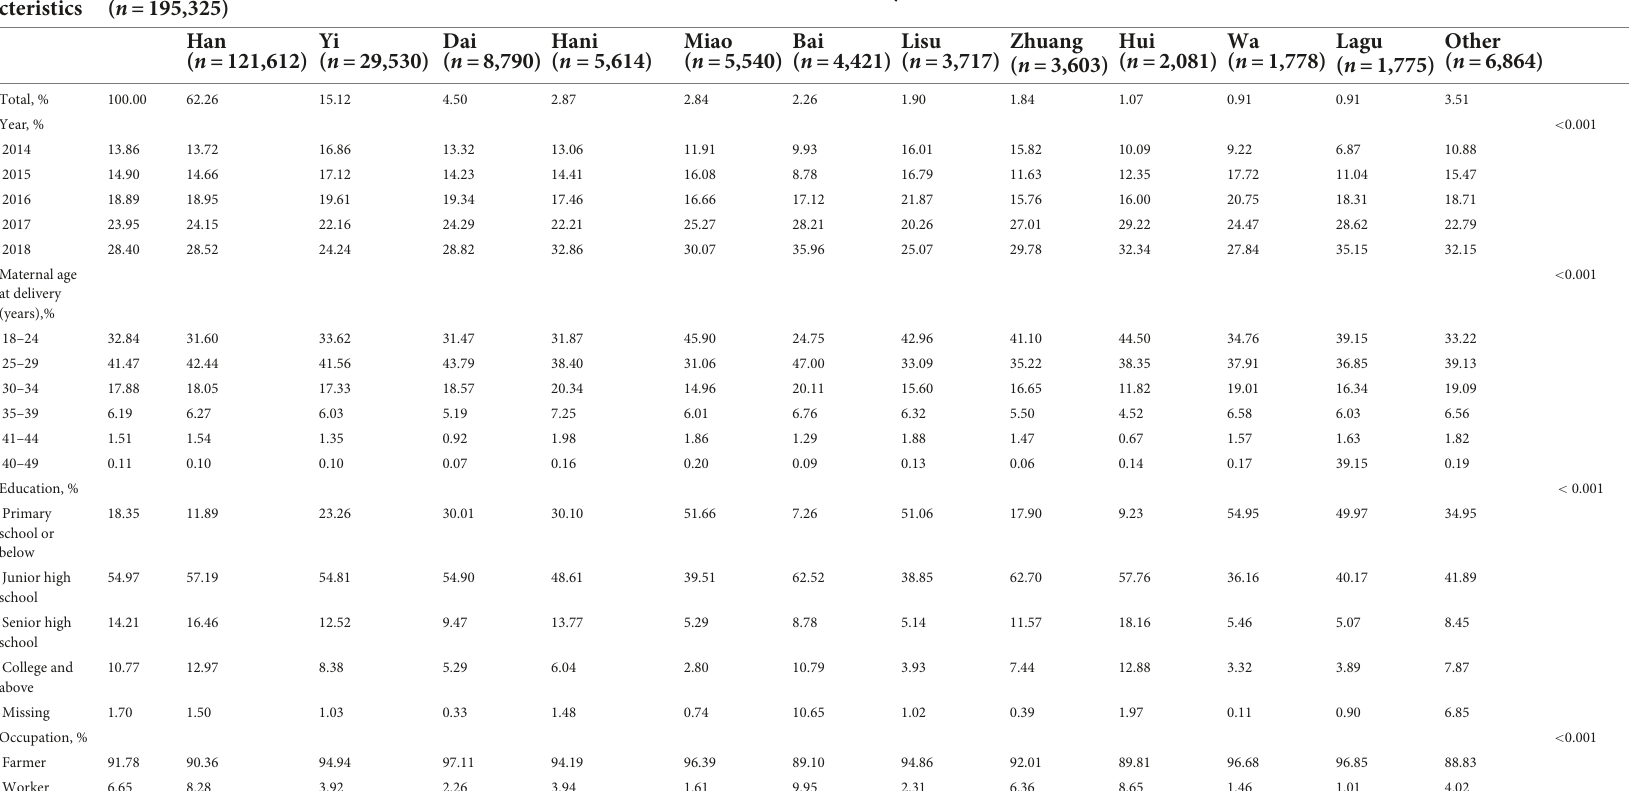
TABLE 1 Maternal characteristics with respect to ethnicities in rural Yunnan, Southwest China, 2014–2018. Chara- Total cteristics ( n =195,325)